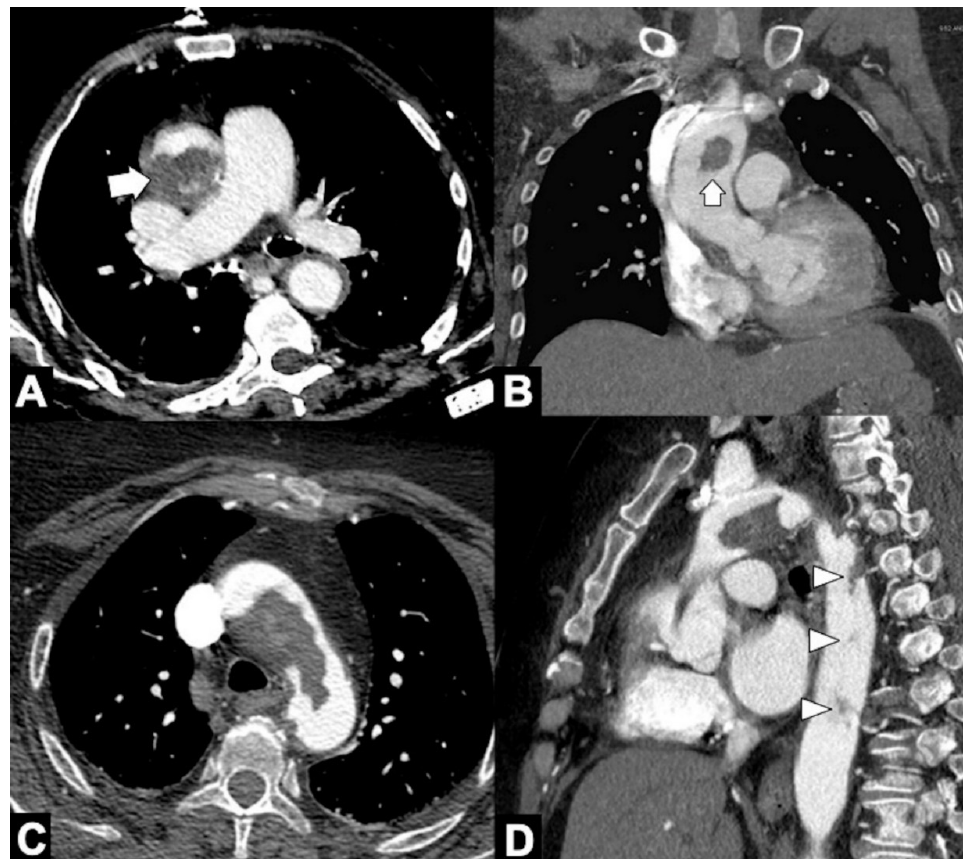
Figure 15. CTA of acute diffuse aortic atheromatous embolization in a 46-year-old COVID-19 pneumonia patient with acute cerebral vascular event. ( A ) CTA axial scan shows extensive and irregular atheroma of the ascending aorta (arrow). ( B ) Coronal MIP reconstruction image confirms ascending aorta filling defect (arrow). ( C ) In the same patient, CTA axial scan shows extensive irregular atheroma of the transverse aortic arch. ( D ) Sagittal MIP reconstruction image confirms extensive arch atheroma and friable floating thrombi in descending thoracic aorta (arrowheads).